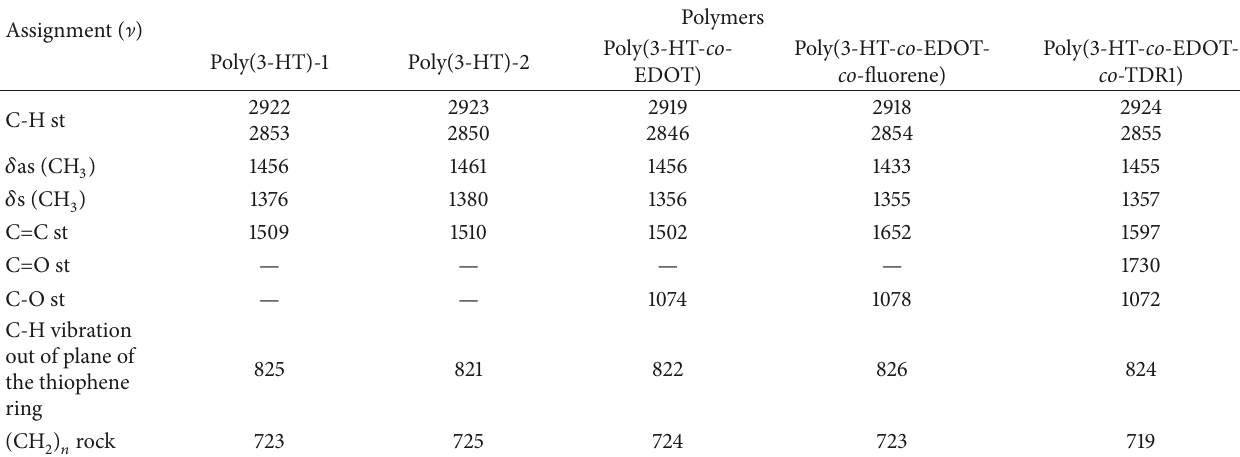
Table 2: Relevant FT-IR absorption bands (cm −1 ) of the polymers.